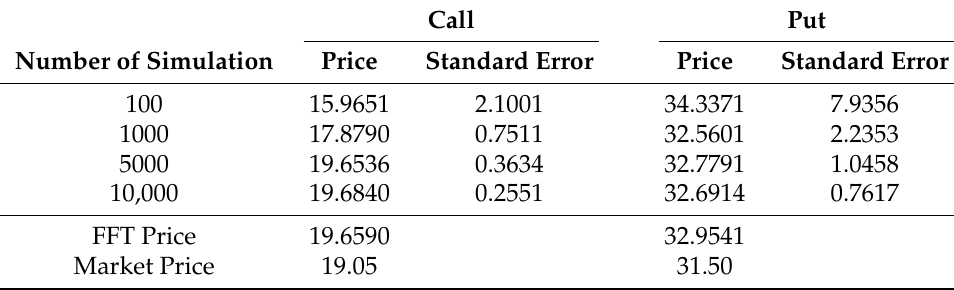
Table 4. MCS prices and standard errors for SPX call and put with the strike price K = 2500 and time to maturity T = 28 days using calibrated parameters on 11 September